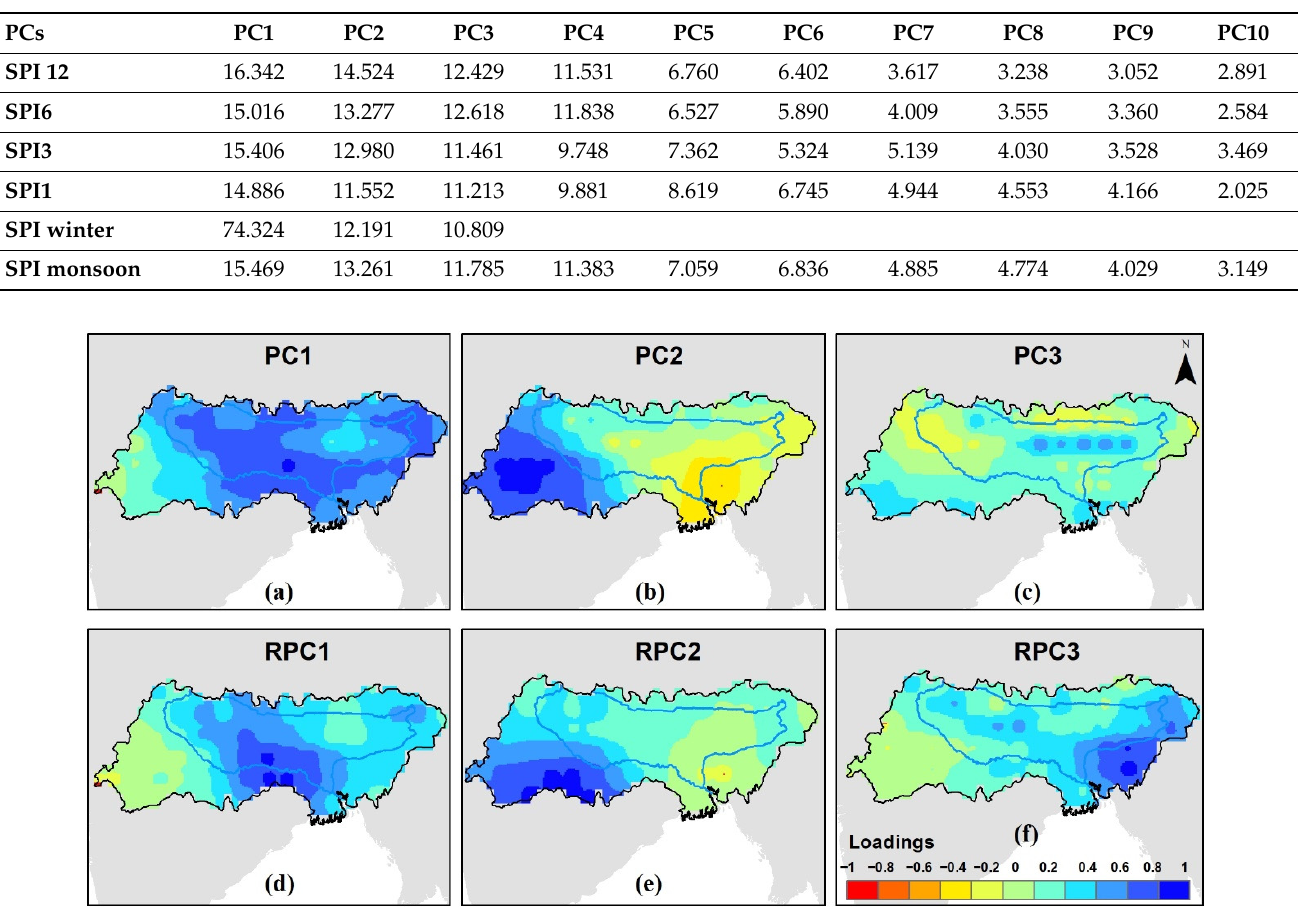
Figure 8. Loading patterns of three principal components of 12 month SPI ( a – c ) and rotated loadings ( d – f ).